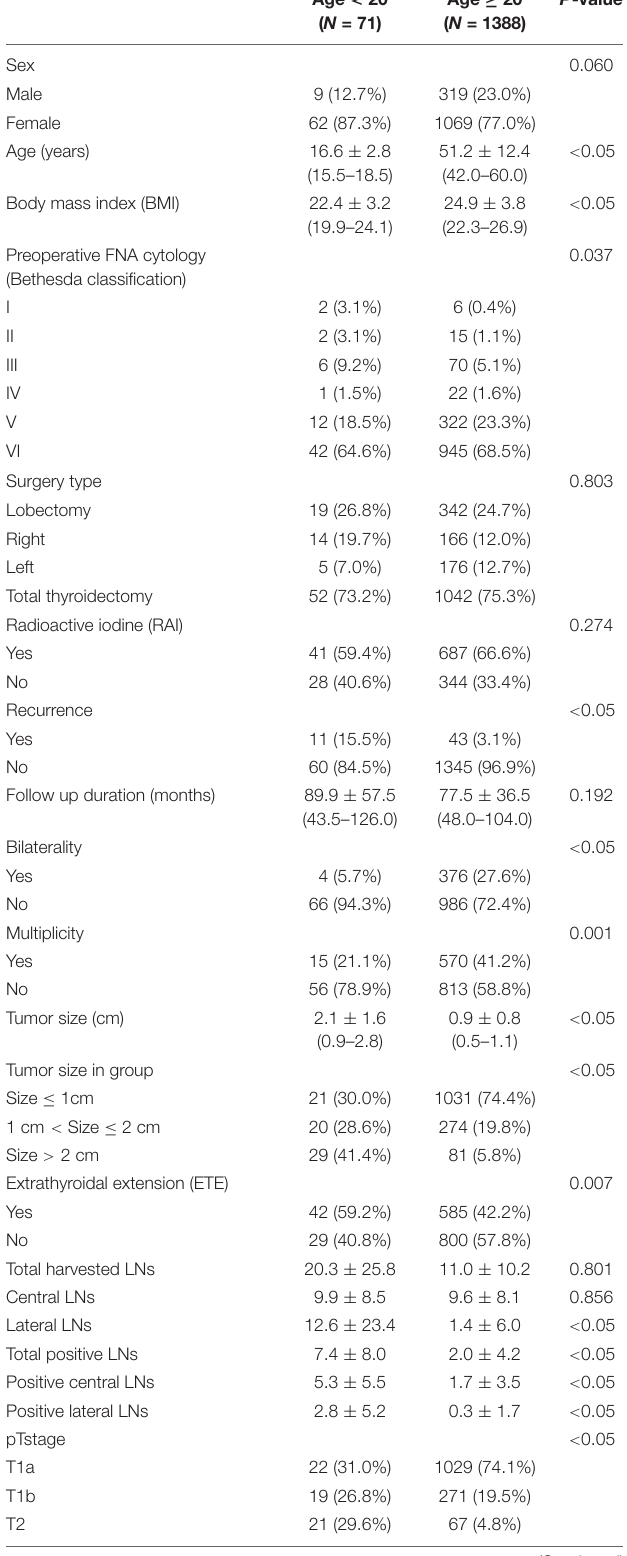
TABLE 1 | Clinico-pathologic characteristics of patients according to age